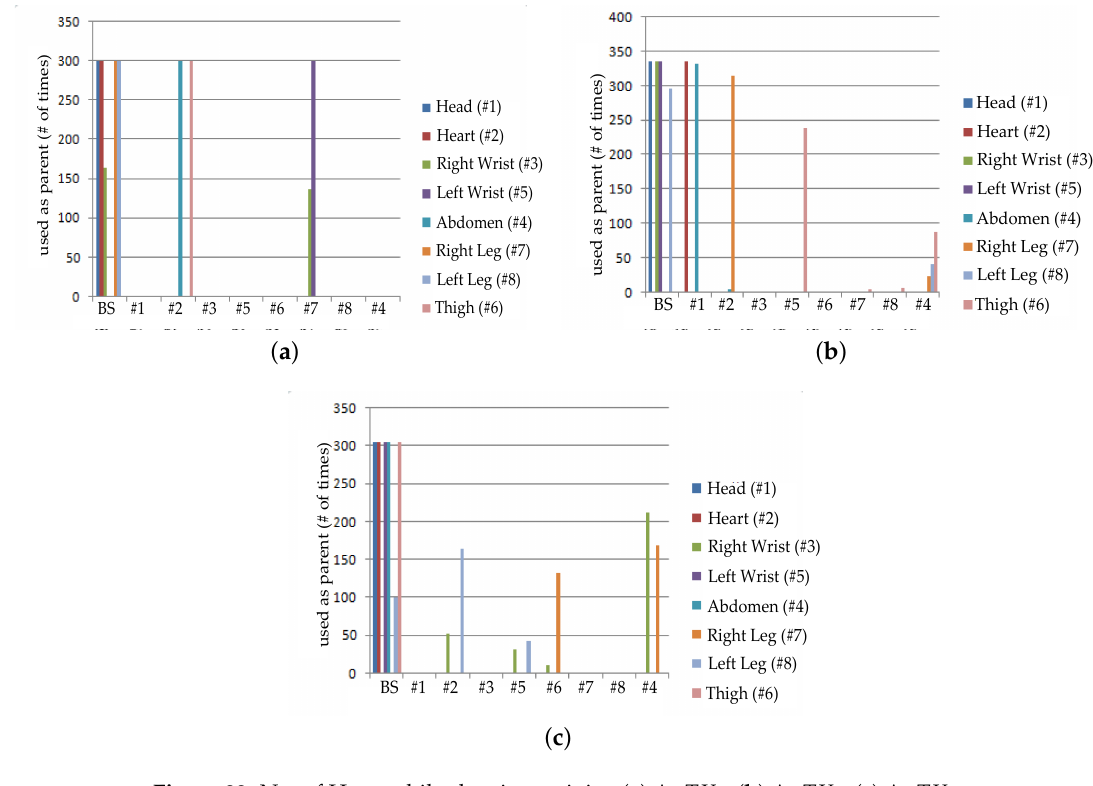
Figure 22. No. of Hops while sleeping activity. ( a ) At TX 2 ; ( b ) At TX 3 ; ( c ) At TX 4 .